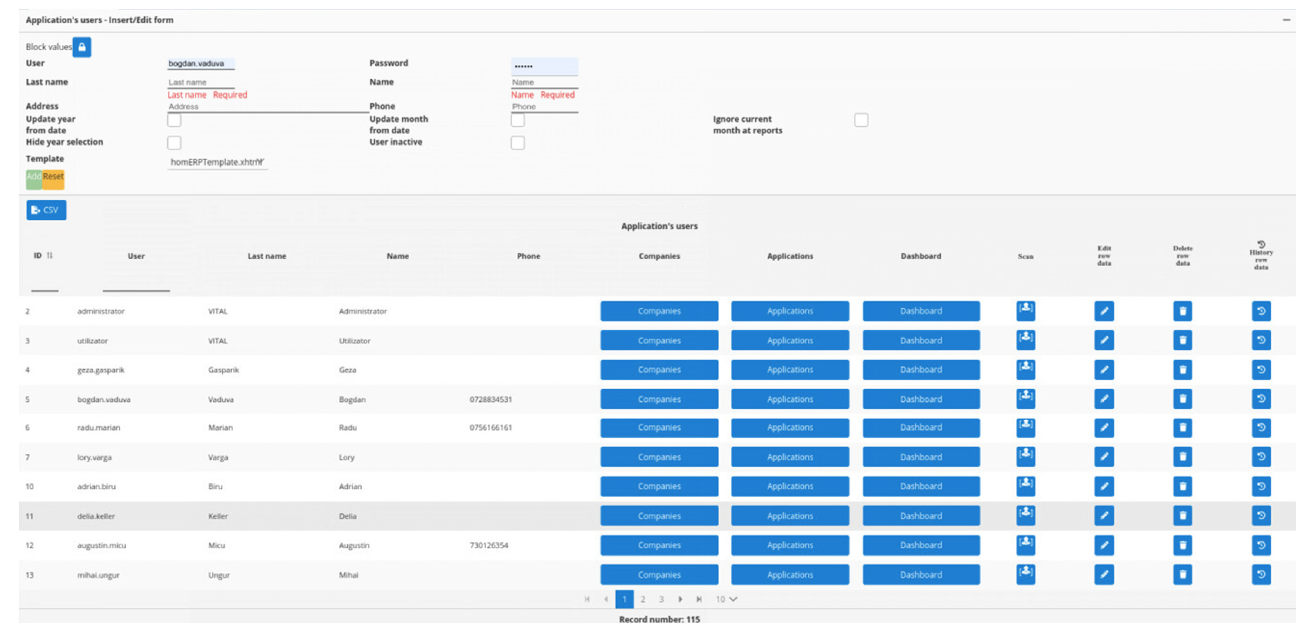
Figure 10. JavaScript/Angular 2+ “one4all” framework example—edit view. This company’s SCADA project was initially intended to be used in read ‐ only mode, which means no PLC commands were implemented. After a while, the necessity to send commands to different PLCs arose and was added. Sending commands to PLCs can be easily implemented using the Modbus TCP/IP standard, thus making it just a click away from any user. Of course, all the commands have to have a higher security level, which means that a command can only be sent after user retype their own password. Talking about the performance of the SCADA project built using the “one4all” tool, we must mention the total number of data tags that are in use. That number was, at the time this article was written, around 27,000 data tags and the application’s loading time for a computer view was about 7 s and that for a mobile device was about 10 s, but those numbers differ based on the computer’s and mobile device’s hardware specifications. 6. Conclusions/Future Works The SCADA project was built using a “one4all” tool, so it can be easily implemented to other companies such as electrical, gas or any type of production. This will mean that